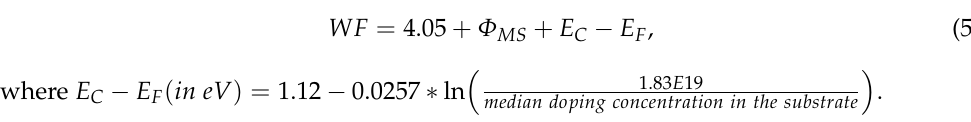
Figure 7. The intercepts from the part 1 fit are plotted as a function of high-k EOT. A second order fit is performed to extract the metal work function.